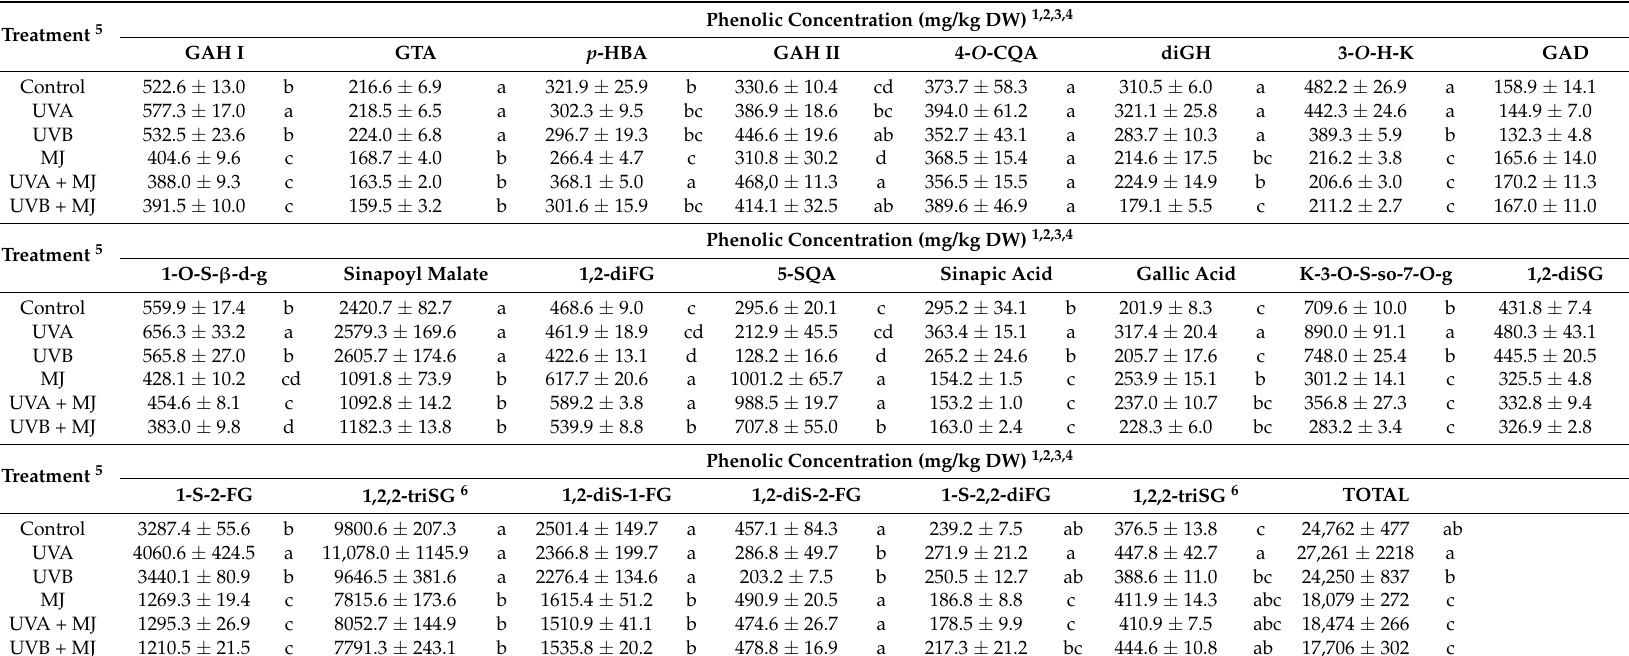
Table 4. Concentration of individual and total phenolic compounds in broccoli sprouts treated with UVA or UVB light, methyl jasmonate or a combination of stresses. Treatment 5